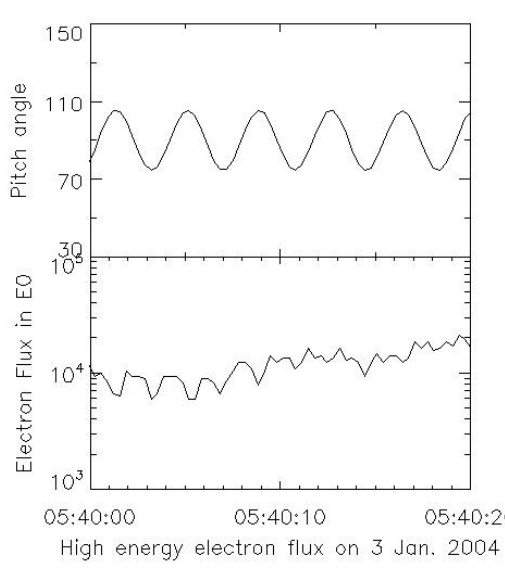
Fig. 9. Temporal variation of the high energy electron flux at E0 (0.2–0.4MeV) during the time interval 05:40:00–05:40:20 on 3 Jan- uary 2004.